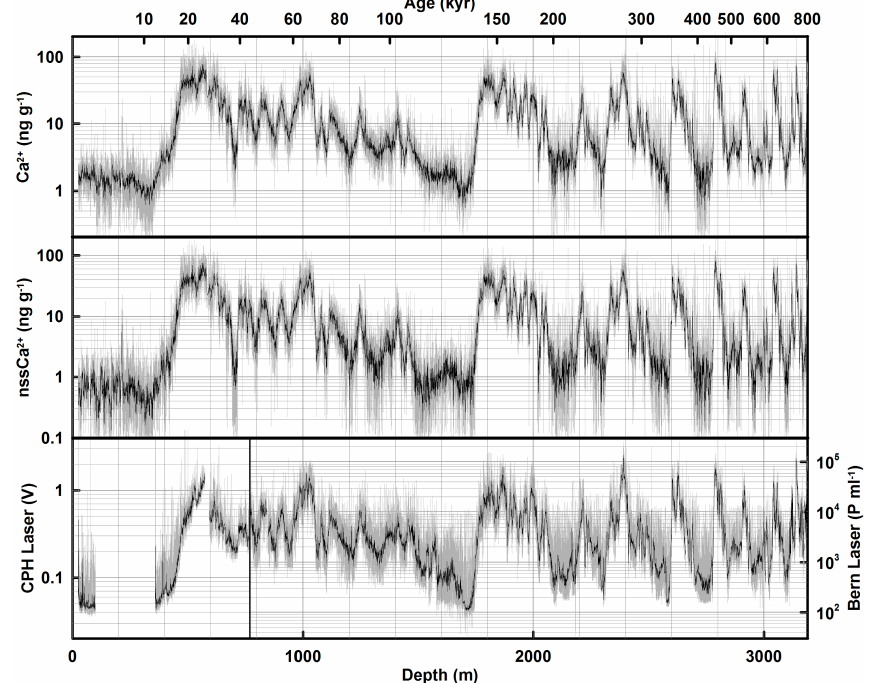
Fig. 1. Calcium, non-sea-salt calcium, and dust data at 1cm resolution (grey), overlaid with 55cm median values (black) from EPICA Dome C CFA on the depth scale. The EDC3 time scale in kyr is indicated on top. Dust was not measured between 100 and 358m depth. Note that the CPH and Bern dust data have different